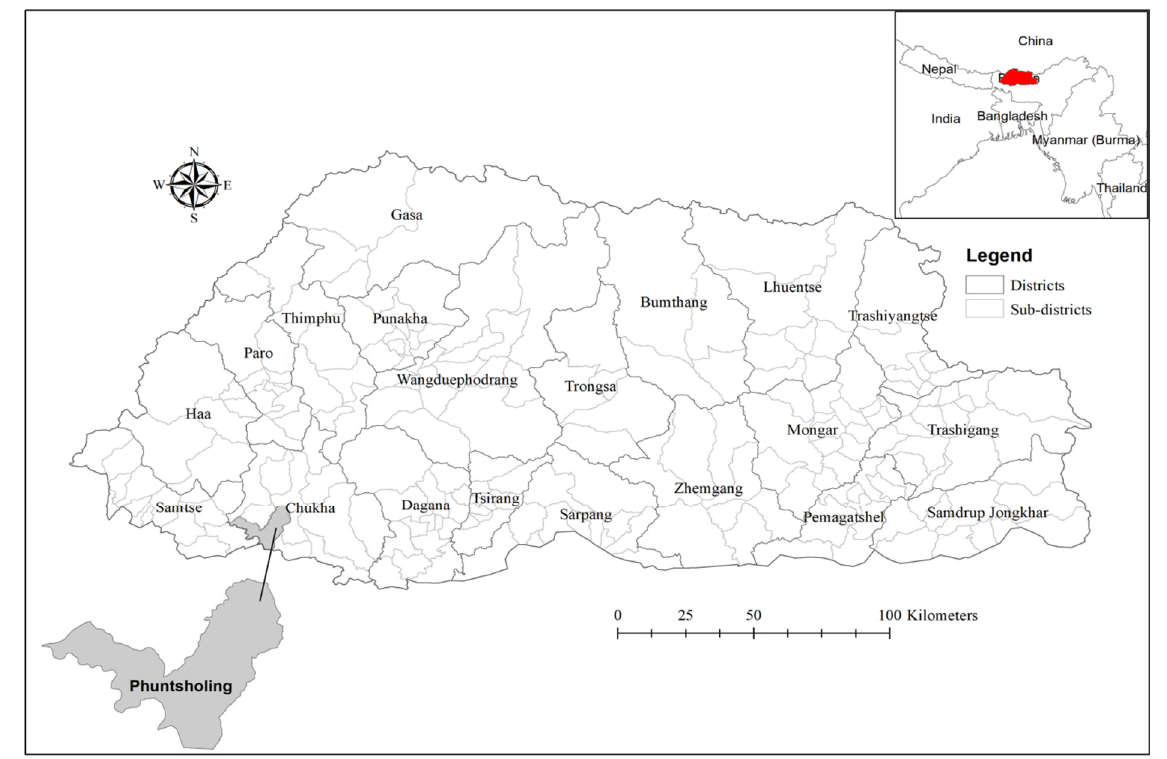
Figure 1. Political map of Bhutan showing Phuentsholing, the site of this study.